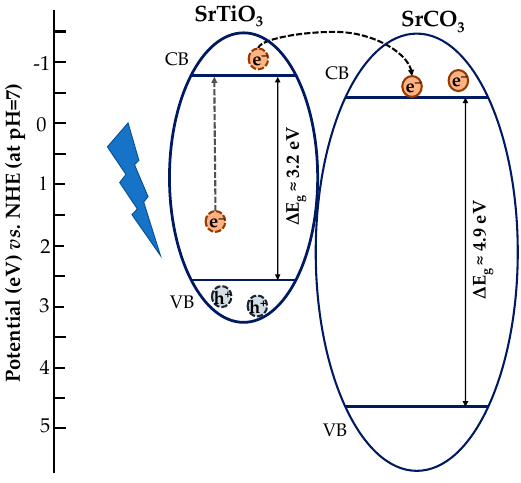
Figure 8. Scheme of the mechanism in SrTiO 3 -SrCO 3 [19,51].